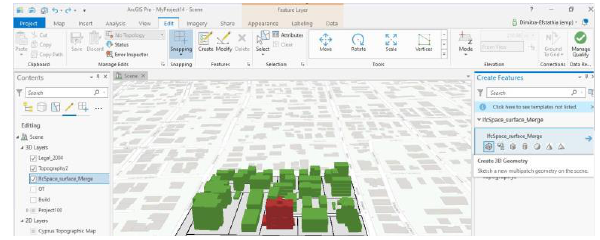
Figure 4. Integrated BIM - GIS model Source: Result of processing in ArcGIS Pro